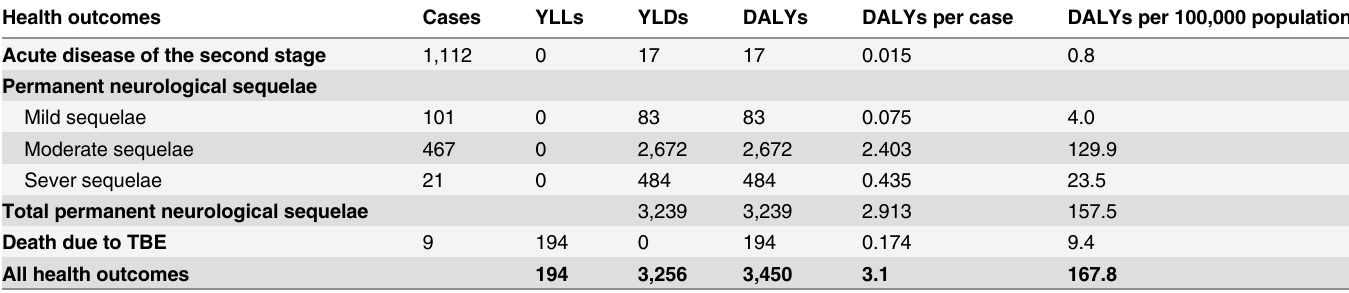
Table 2. Calculated DALYs due to TBE for one year from the population perspective (YLLs, YLDs, DALYs and DALYs per 100,000 population) and individual perspective (DALYs per case).